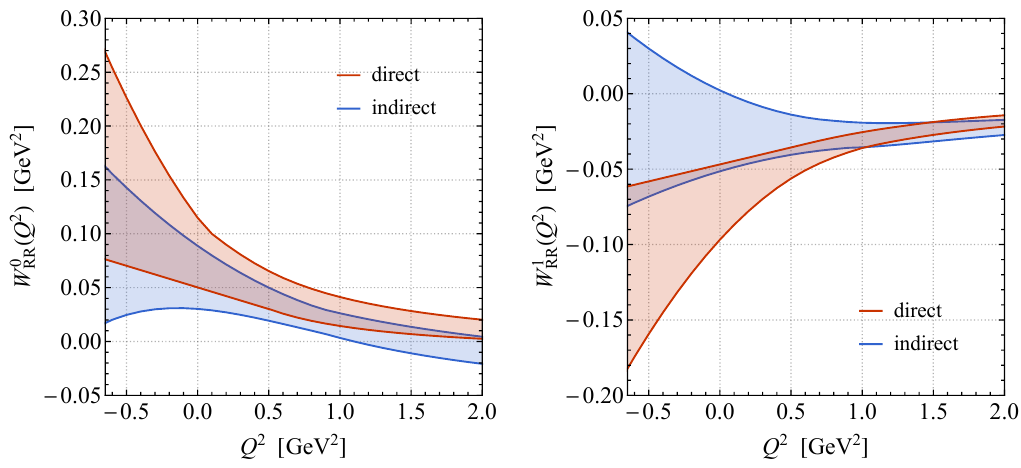
Figure 4 . Comparison of the form factors W 0 ( Q 2 ) (left panel) and W 1 ( Q 2 ) (right panel) ob- RR RR tained by the direct calculation and the indirect method based on the relations (C.6) and (C.7). The results of the direct (indirect) computation are indicated in red (blue) and the coloured envelopes include all possible solutions found in [19] and (5.1) to (5.4), respectively. Further explanations can be found in the main